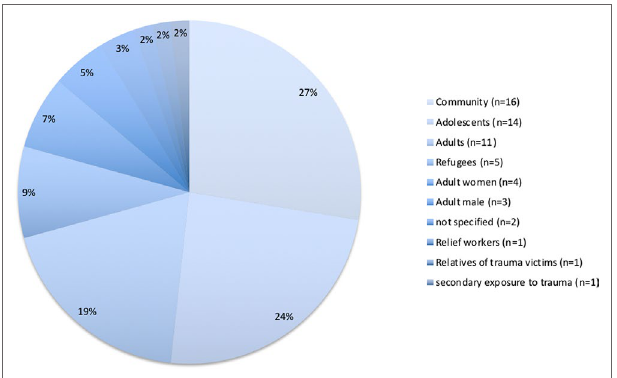
FIGURE 4 | Proportions of different populations studied that were